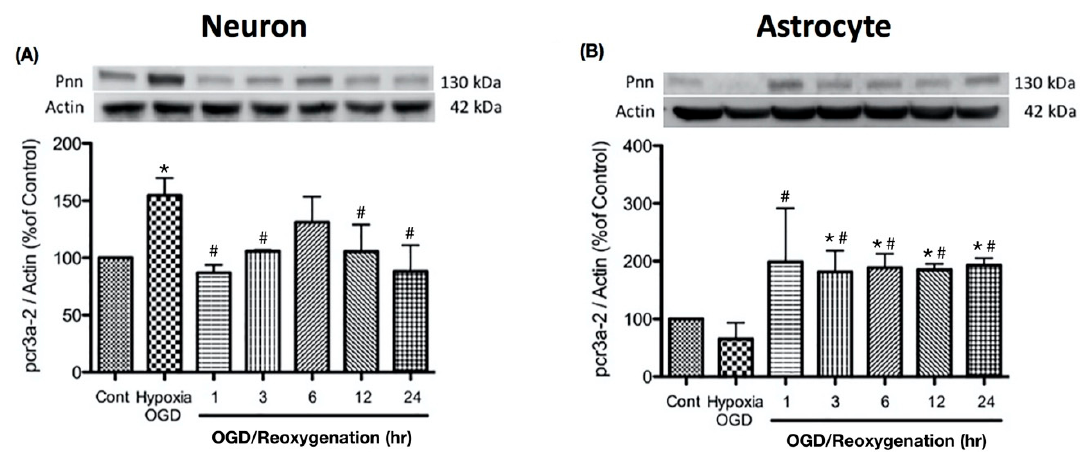
Figure 2. Oxygen-glucose deprivation treatment regulated the expression levels of Pnn in primary cultured cortical neurons ( A ) and astrocytes ( B ). Western blotting was used to examine the expression levels of Pnn after oxygen-glucose deprivation (OGD) treatment and at different time points during reoxygenation. OGD, oxygen-glucose deprivation; * indicates p < 0.05 in comparison with control group; # indicated p < 0.05 in comparison with OGD group; n = 6 for each group.